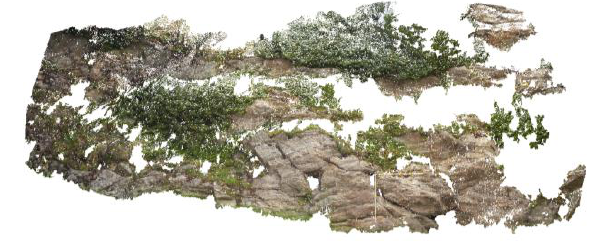
Figure 13. Pix4D Smartphone dense point cloud